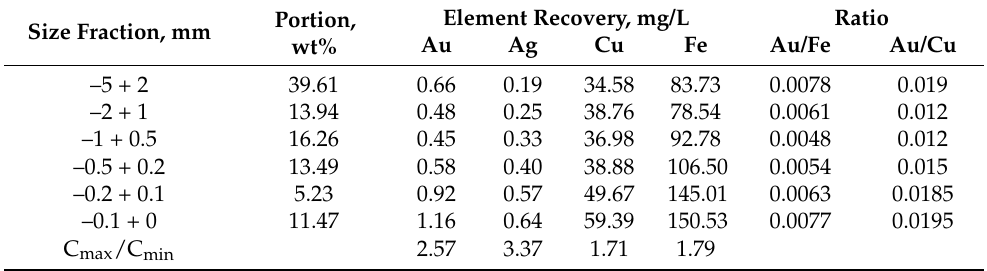
Table 1. Recovery of Au, Ag, Cu and Fe) from various size fractions of oxidized sample of Malmyzh deposit by hot